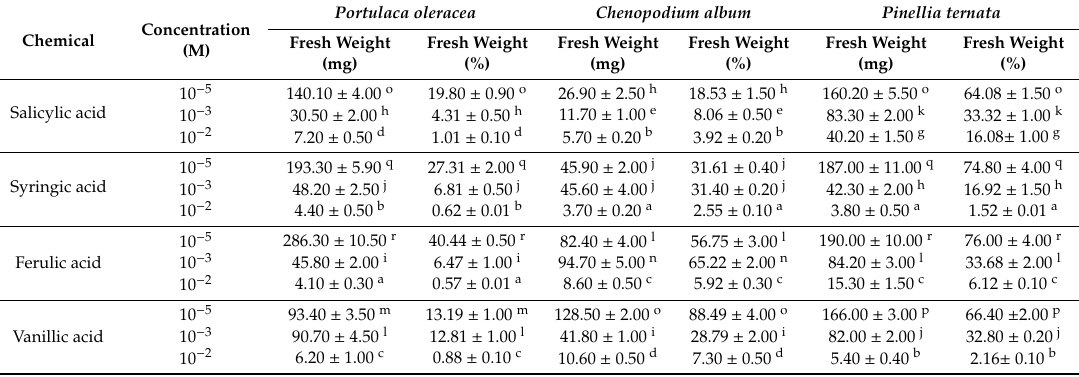
Table 2. E ff ect of the standard phenolic compound on the fresh weight of